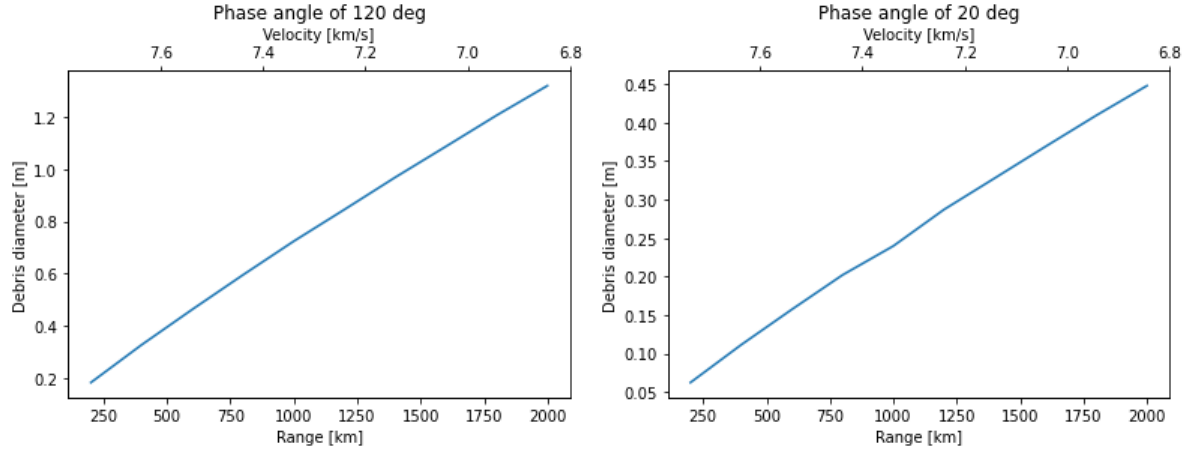
Figure 7. Debris size in the function of the distance from a ground-based sensor and their corresponding orbital velocity, assumed to be circular, for phase angles of 120 deg and 20 deg.